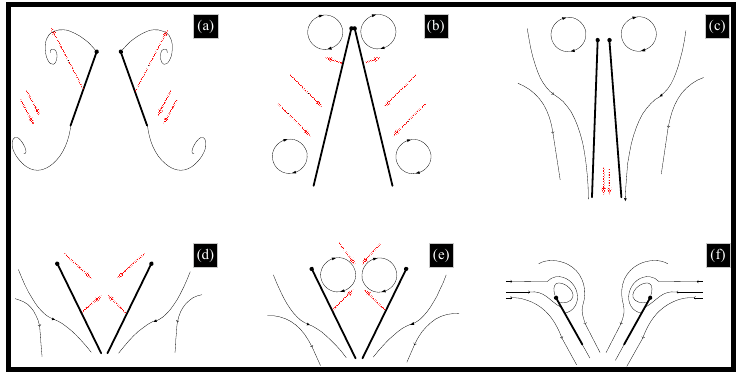
Figure 6. Clap-and-fling mechanism.